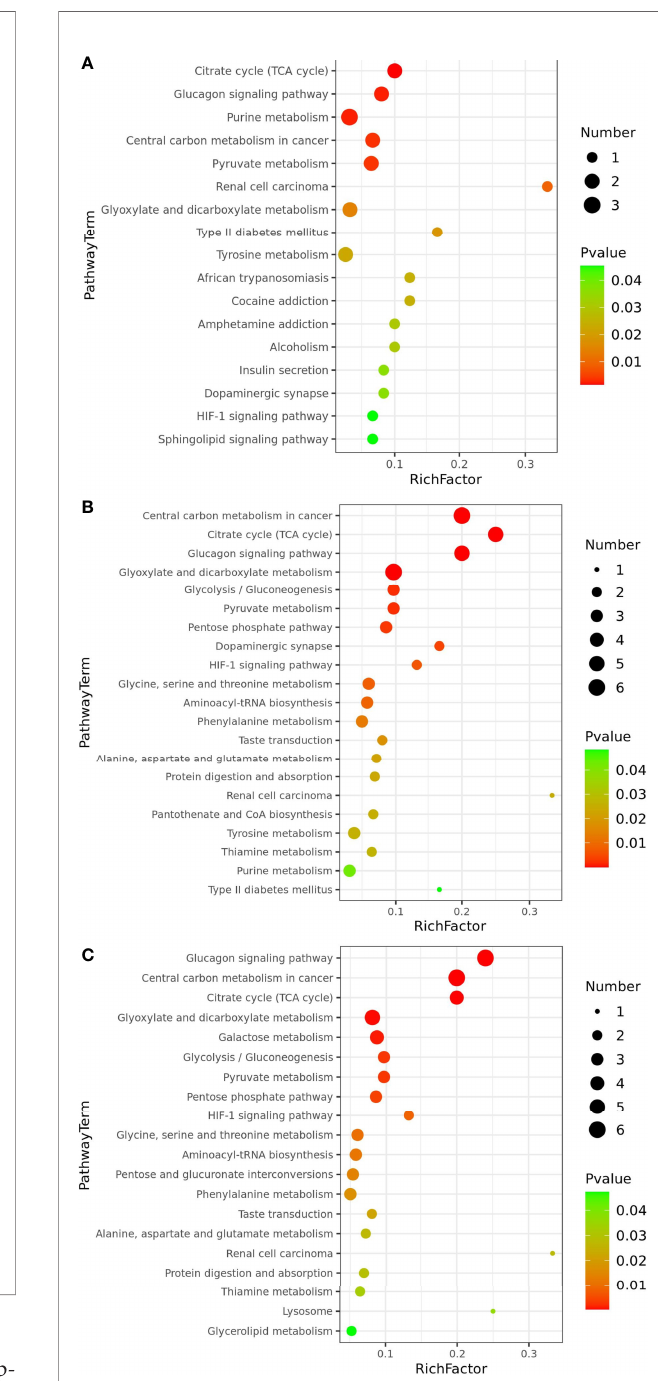
FIGURE 6 | Signi fi cantly differential metabolic pathways associated with differential metabolites (p<0.05): LCvsNC group (A) , MCvsNC group (B) and SCvsNC group (C)